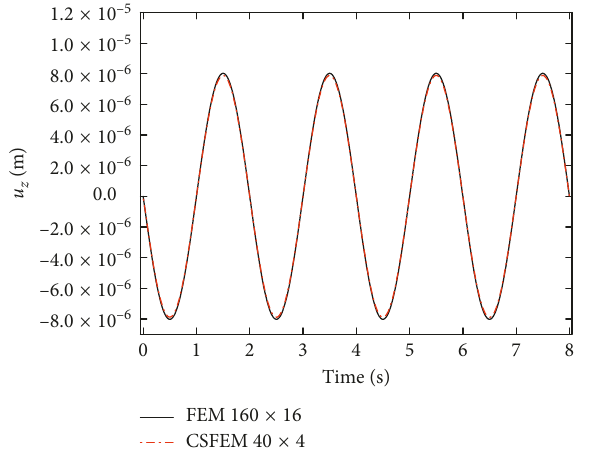
Figure 19: The variation of the displacement u z at point A with respect to